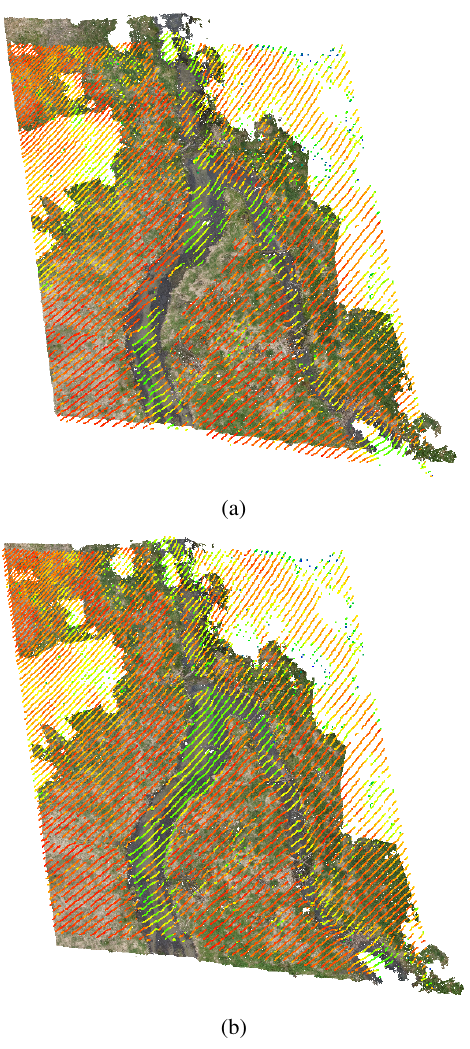
Figure 10. Registration output, shown are the overlayed two point clouds a: output of the proposed method with left misalignement of 3 m b) ground